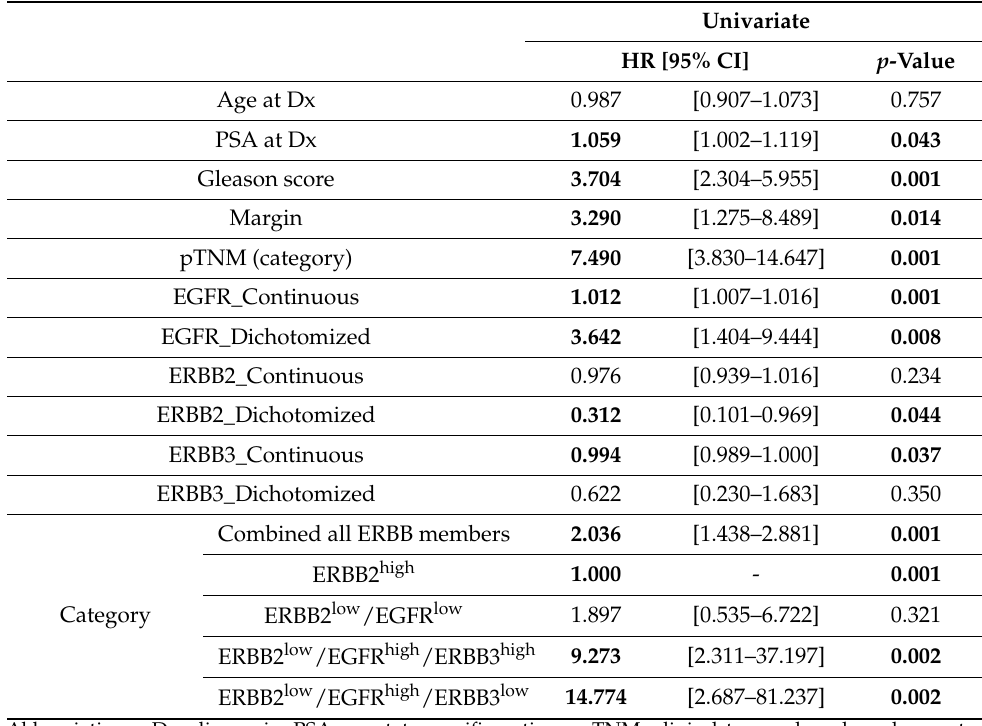
Table 4. Univariate Cox regression analyses of ERBB using the development of bone metastasis at 10 years as an